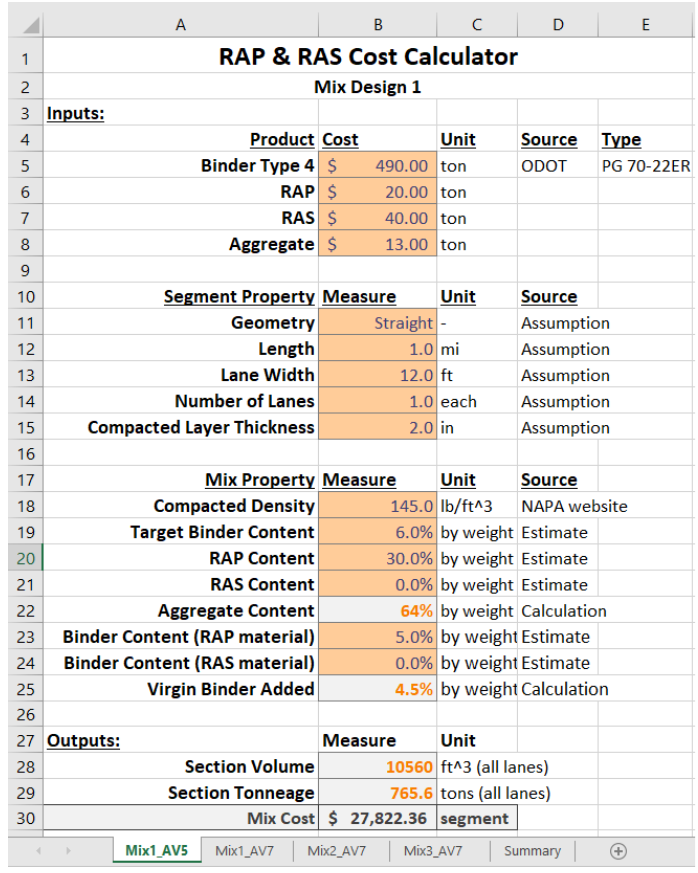
Figure 5. Cost calculation tool input tab.